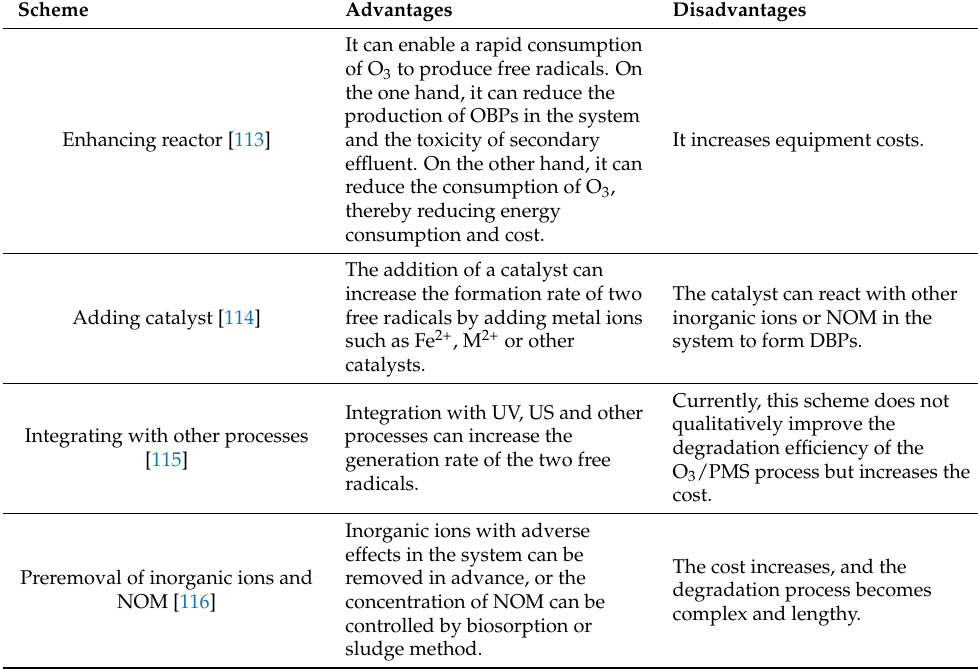
Table 6. Recommendations for improvement of the O 3 /PMS